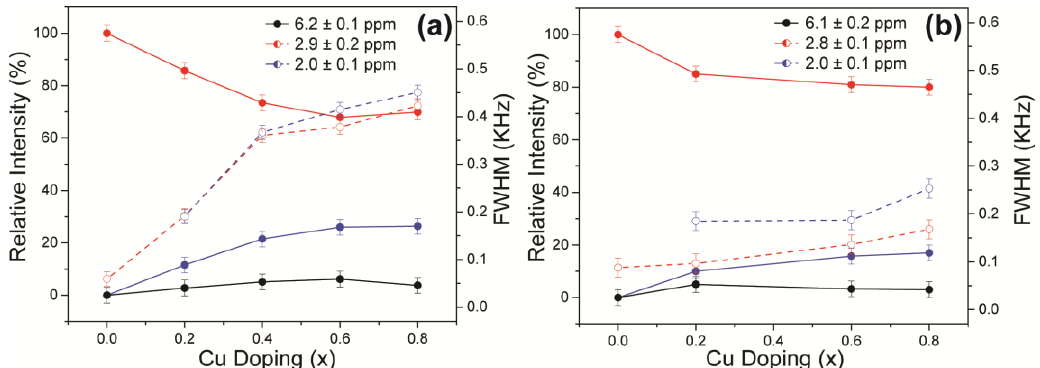
Figure 9. The quantitative estimates of the evolving P speciation with increasing Cu doping as determined by 31 P MAS NMR measurements on the suites of Cu-doped HA samples prepared by the ( a ) solid-state and ( b ) wet chemical synthetic routes.